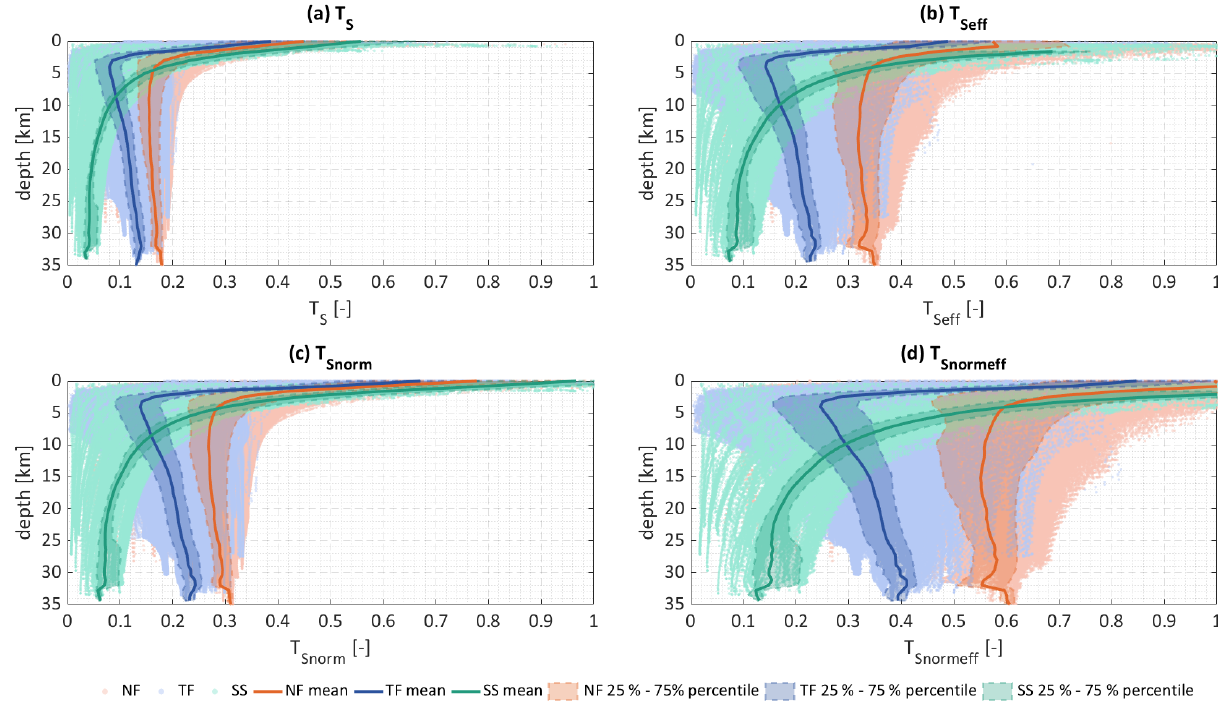
Figure 8. All four slip tendency types at each data point of the Andersonian fault set are plotted vs. their depth. The mean slip tendency is plotted as a solid line; the 25%–75% percentile is shown as a shaded area. Due to the different behavior of normal, thrust and strike-slip faults, the three fault types are colored individually. Data corresponding to the normal faults are shown in orange, data corresponding to thrust faults are shown in blue, and data corresponding to strike-slip faults are shown in mint color.